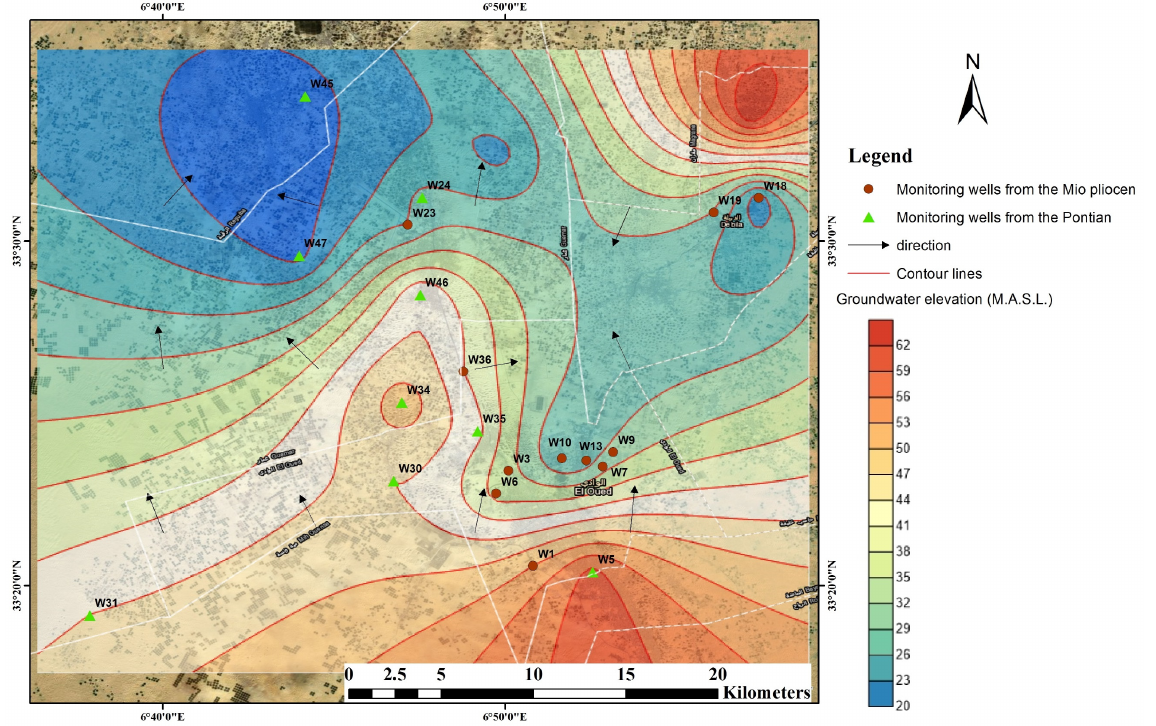
Figure 3. Piezometric map and groundwater flow of the complex terminal aquifer.